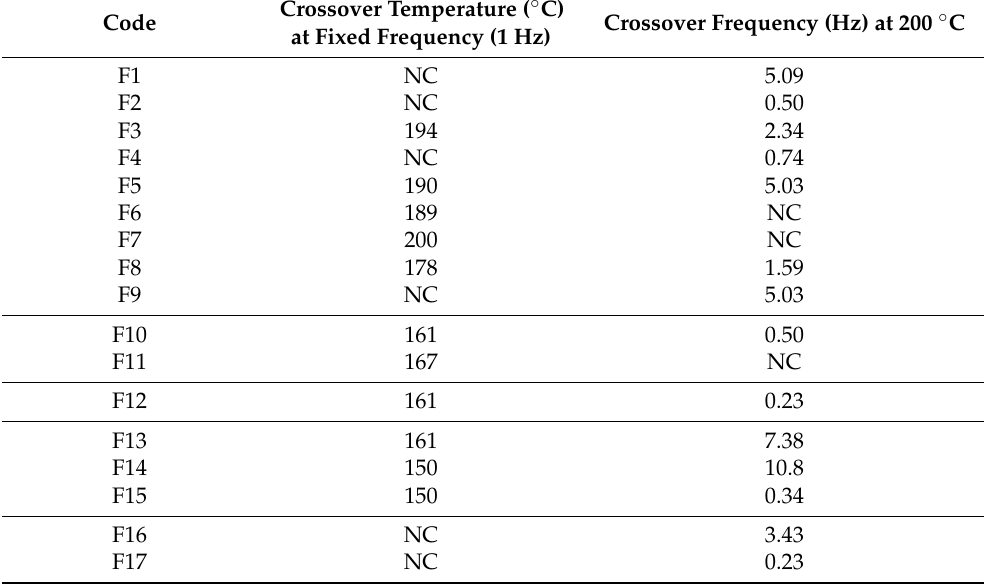
Table 3. Crossover temperature and crossover frequency for all